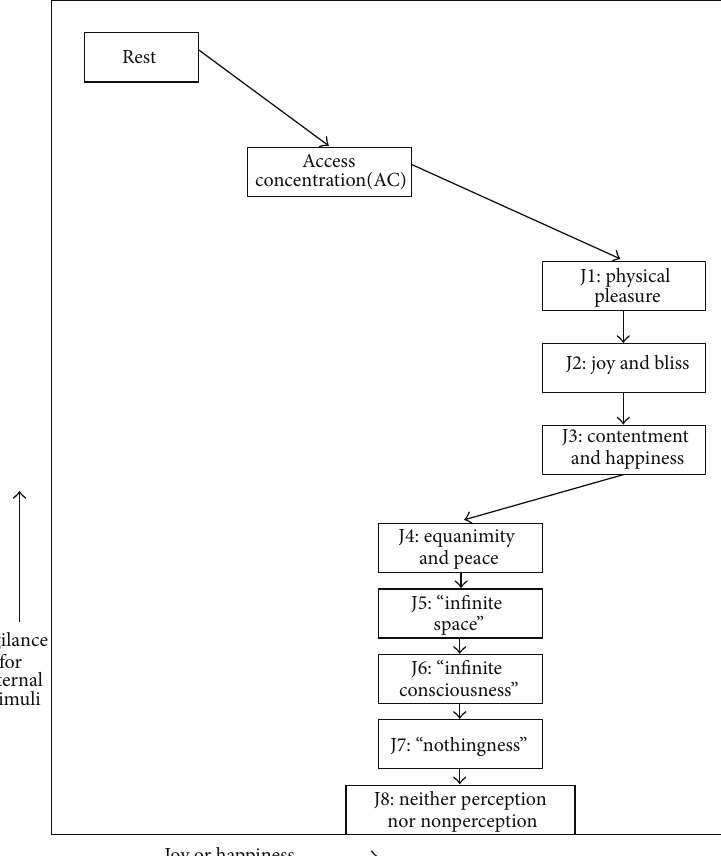
Figure 1: Schematic of the reported experiences in 8 jhanas relative to resting consciousness and access concentration (AC) on 2 dimensions of interest. Joy or happiness is shown on the 𝑥 -axis, and vigilance for external stimuli is plotted on the 𝑦 -axis. The typical meditation sequence is rest to AC to J1, J2, and J3 (the three jhanas highest in joy or happiness), then to J4–J8, all of which are said to be higher in happiness than rest or AC. Each jhana is reported to be deeper and more remote from external stimuli than the